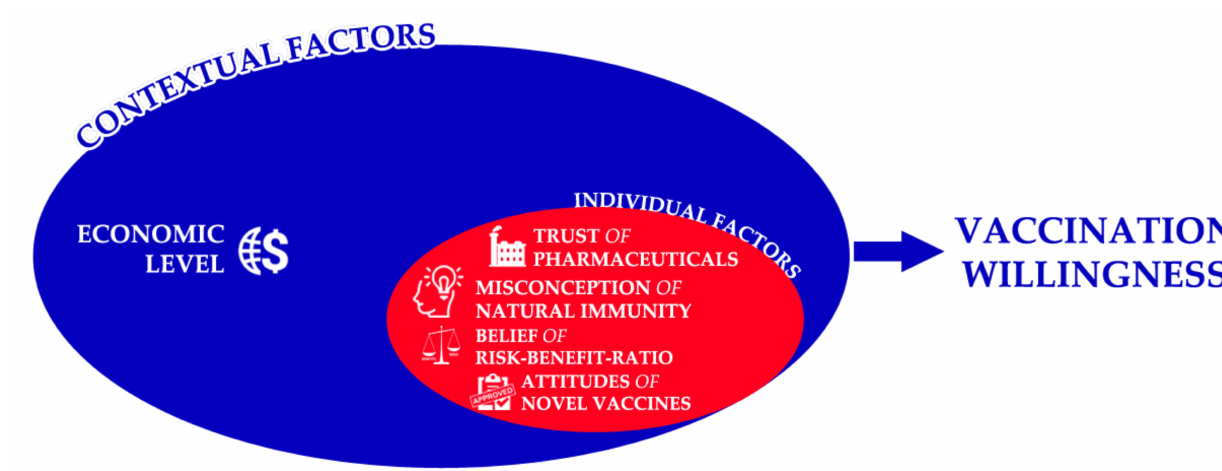
Figure 2. Conceptual map of vaccination willingness predictors according to the socio-ecological theory, February 2021 ( n =